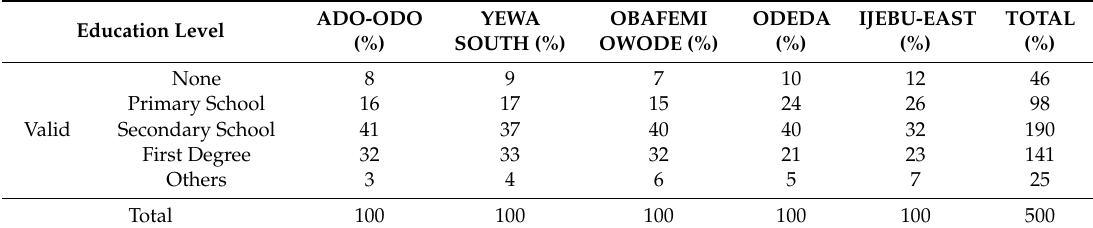
Table 3. Education